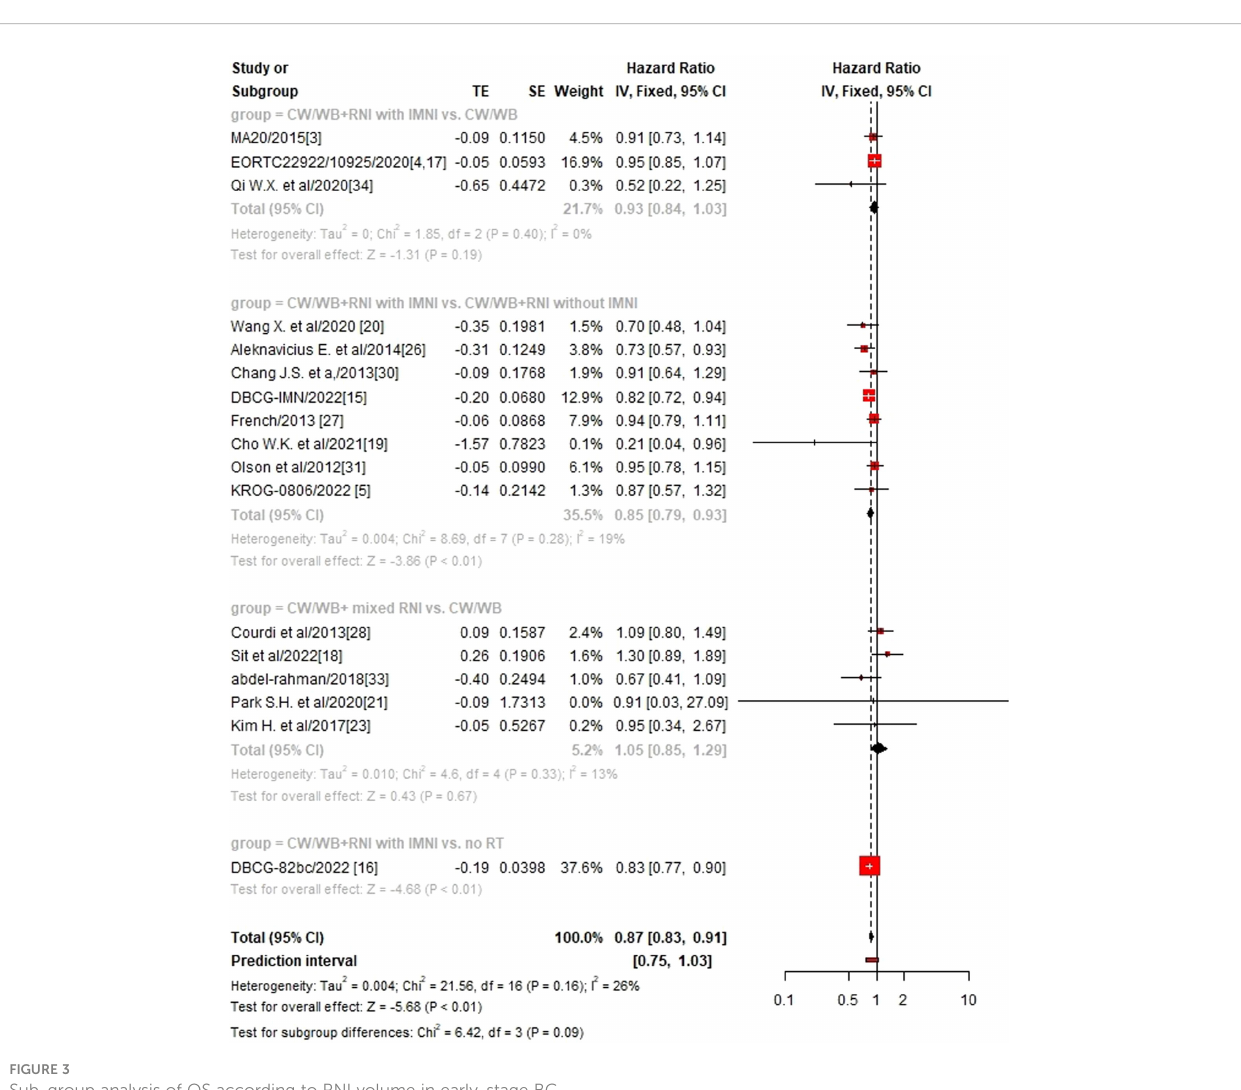
Figure 4C), or CW/WB+SVC (HR 2.24, 95%CI: 0.87 – 5.74,